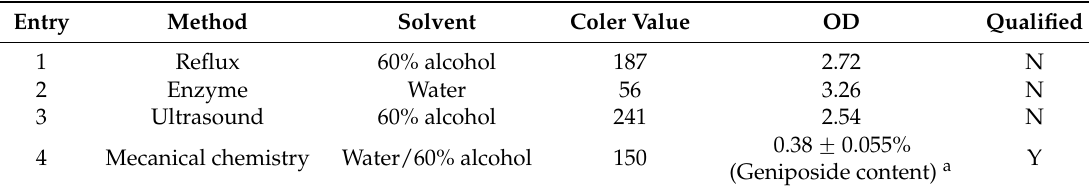
Table 4. Comparison with different methods in gardenia yellow extraction.